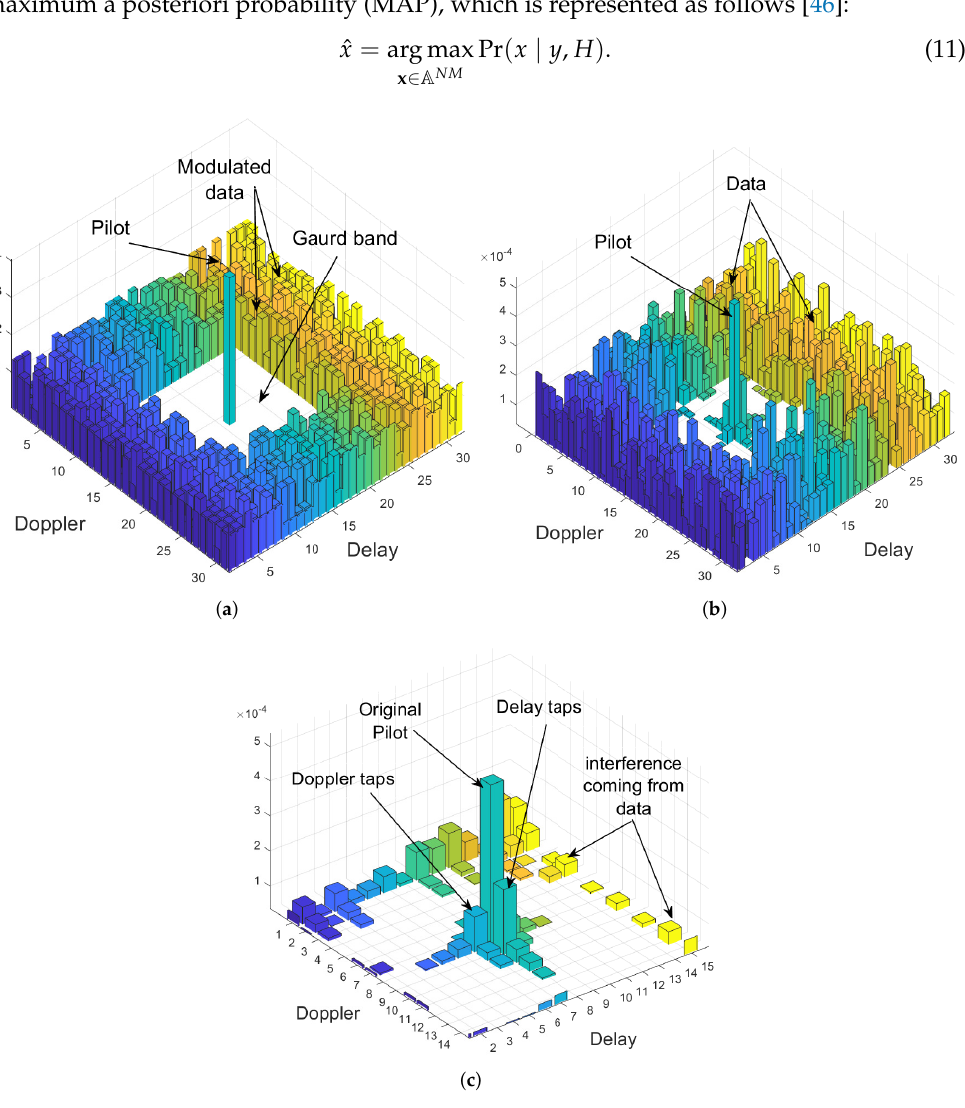
Figure 2. The transmitted and received signal structure in the delay-Doppler plane. ( a ) Transmitted symbols; ( b ) received signal; ( c ) received embedded